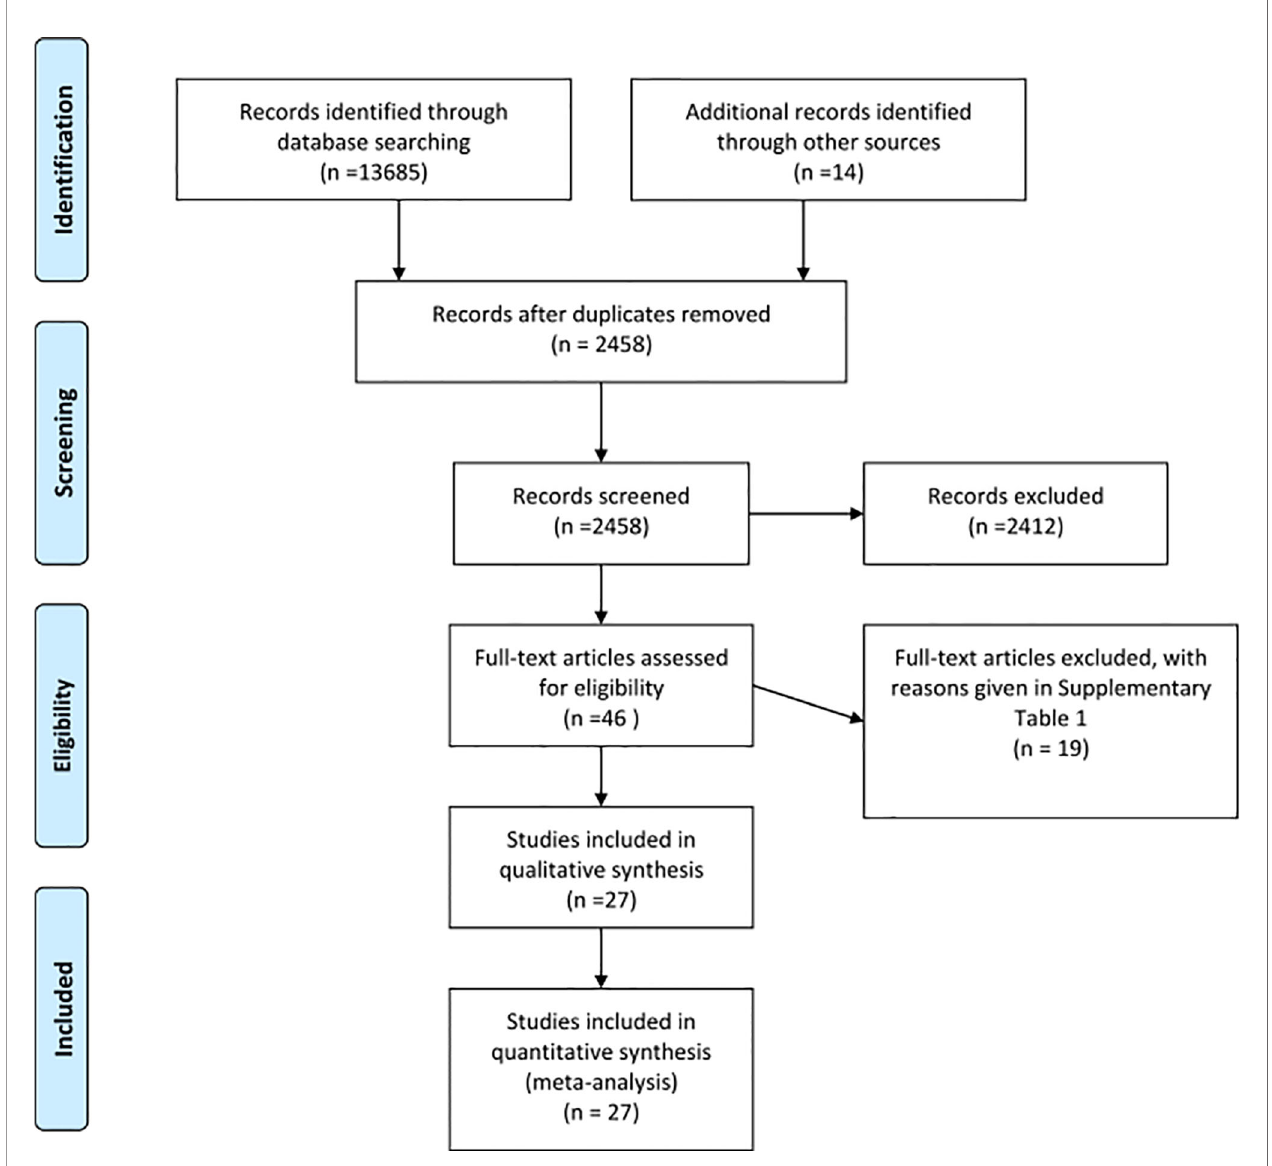
FIGURE 1 | PRISMA fl ow diagram of the search results and number of eligible articles